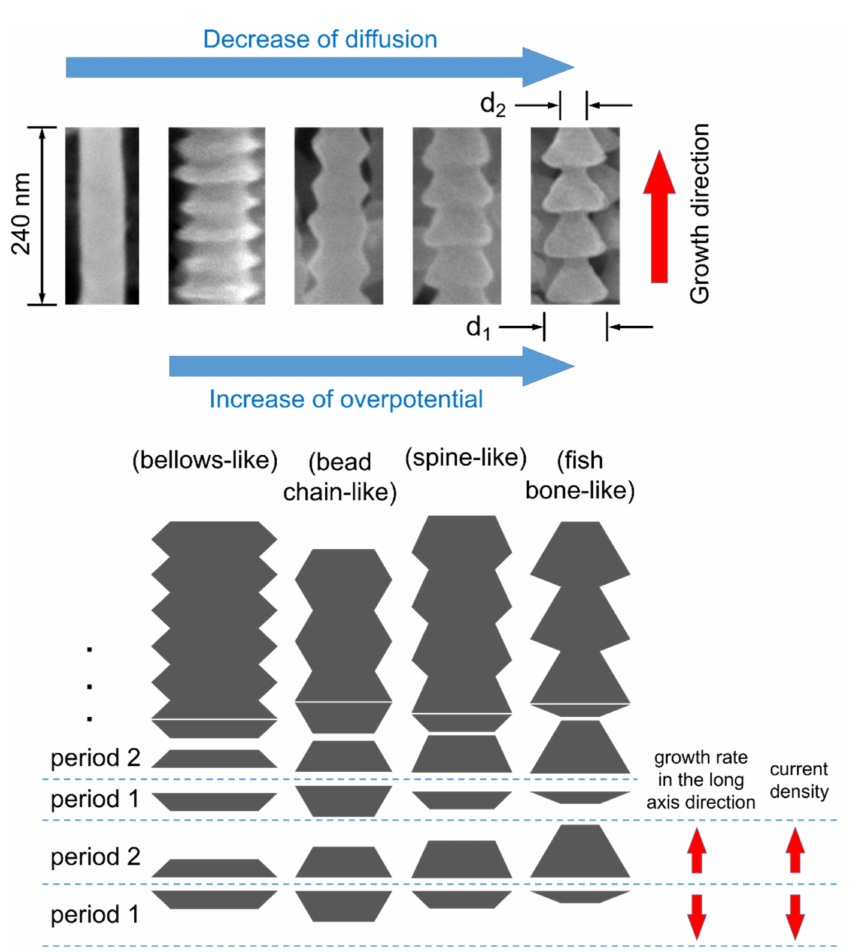
Figure 9. Typical morphologies of Al nanowires in SEM observation and the schematic of the growth